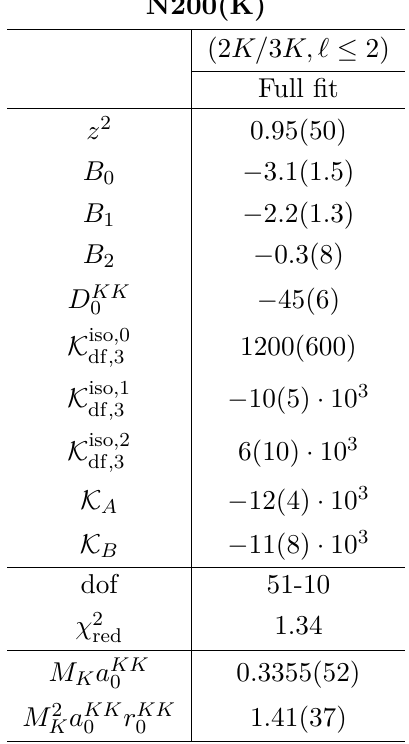
Table 12. Fit results for kaons on the N200 ensemble including all possible parameters at the order we are working, with M K L and levels as in fits 3–5 of table 10.